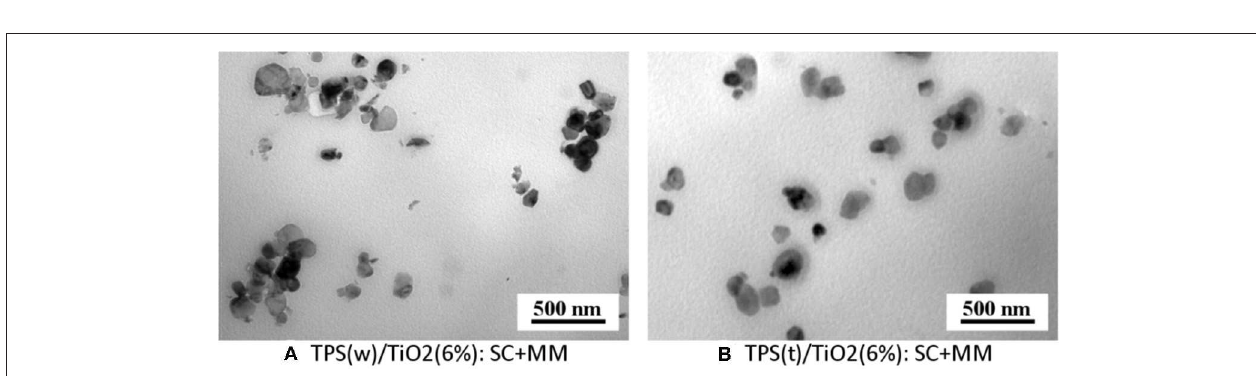
FIGURE 3 | TEM micrographs showing selected TPS/TiO 2 (6%) composites after solution casting and melt mixing: (A) wheat starch composite TPS(w)/TiO 2 (6%) and (B) tapioca starch composite TPS(t)/TiO 2 (6%).